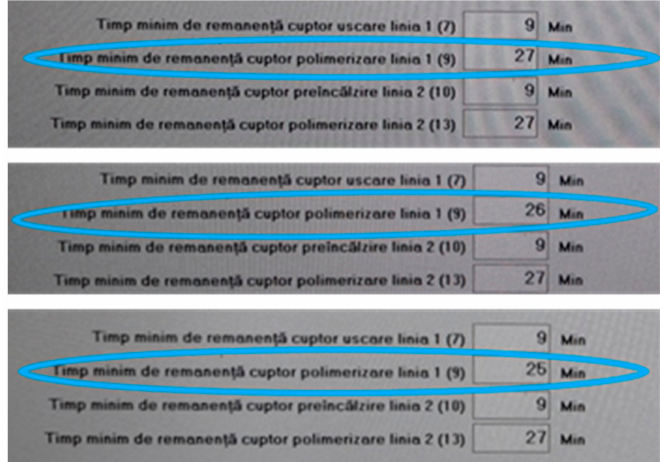
Figure 5. Reduction of polymerization time.